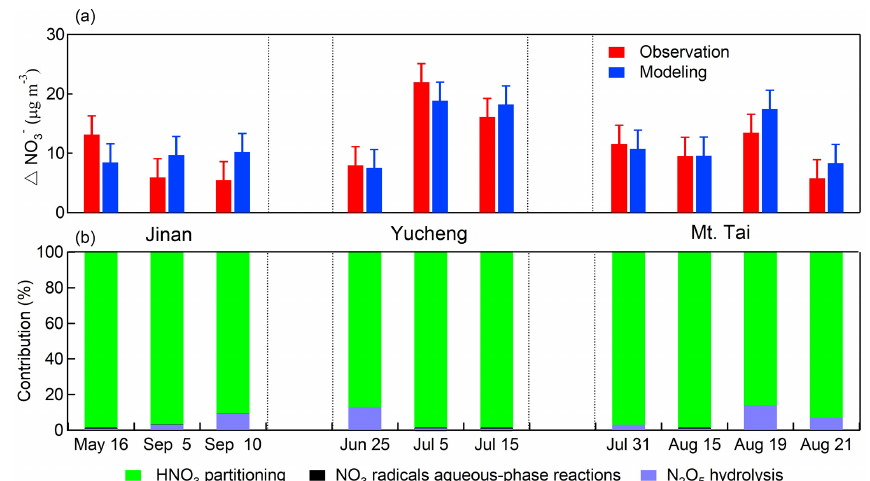
Figure 4. Comparison of the model-simulated versus observed nitrate enhancement (a) as well as the contributions from the major three formation pathways (b) for the daytime cases in urban Jinan, rural Yucheng and Mt. Tai. The error bars are the standard error of the differences between simulated and observed increase in nitrate aerosol.